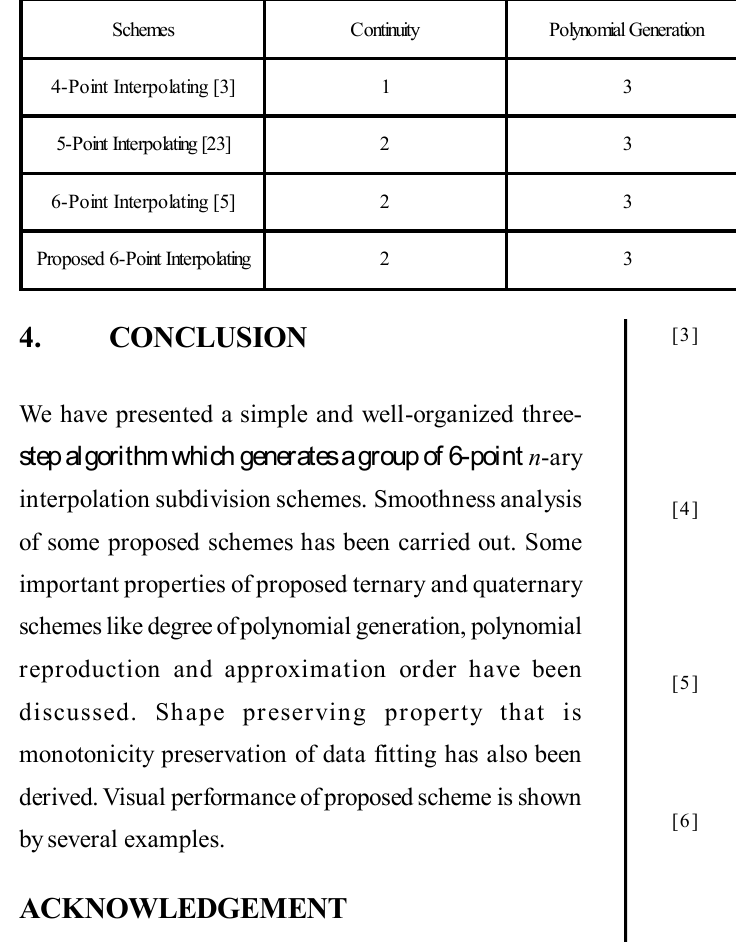
TABLE 2. THE CONTINUITY, POLYNOMIAL GENERATION, POLYNOMIAL REPRODUCTION AND APPROXIMATION ORDER OF THE